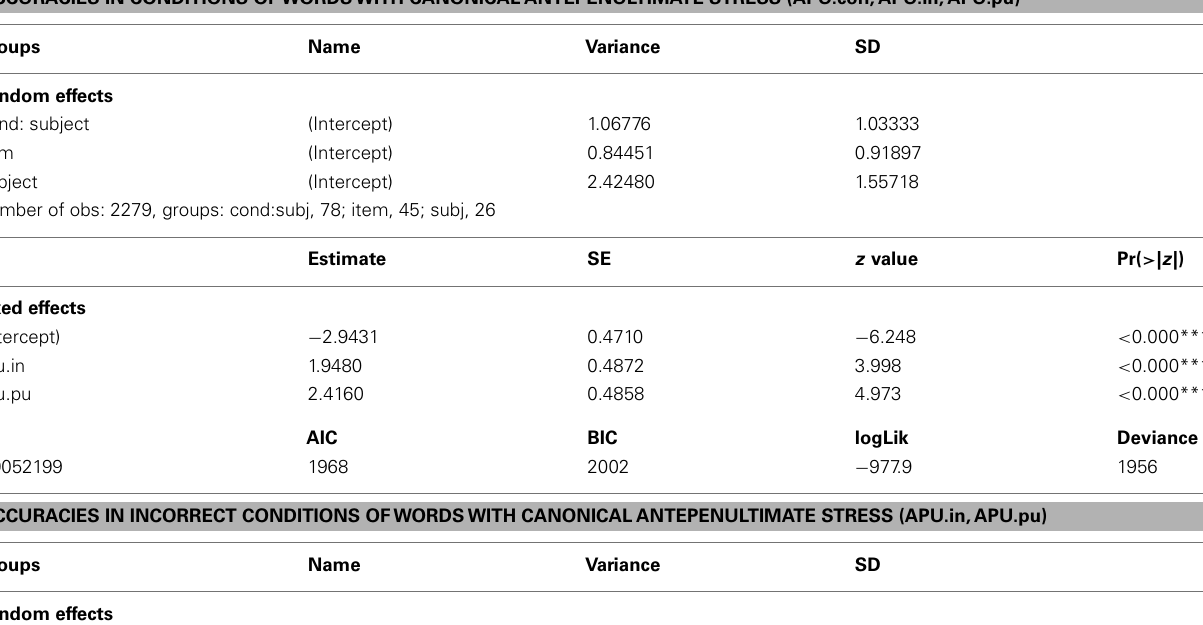
Table 4 | Mixed effects regression models for accuracies over conditions per word